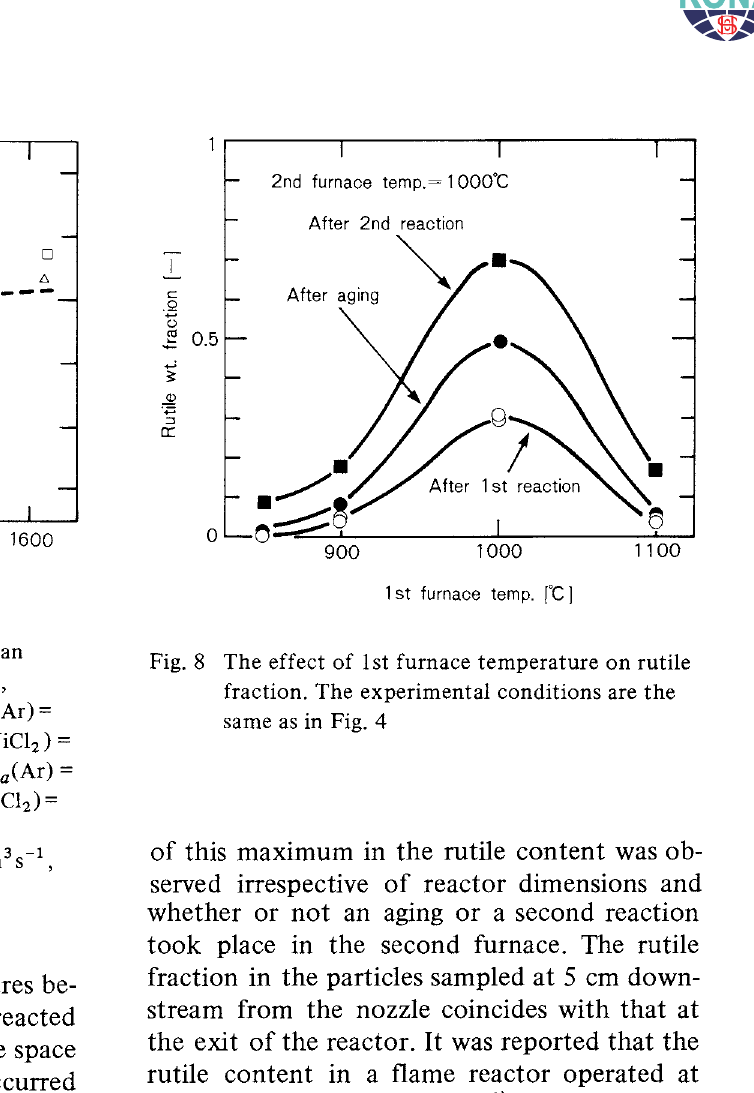
Fig. 7 The effect of temperature on weight-mean particle diameter of nickel. dr = 35 mm, dN=9 mm: o, Qn(Ar)= 11 cm 3 s- 1 , Qa(Ar)=